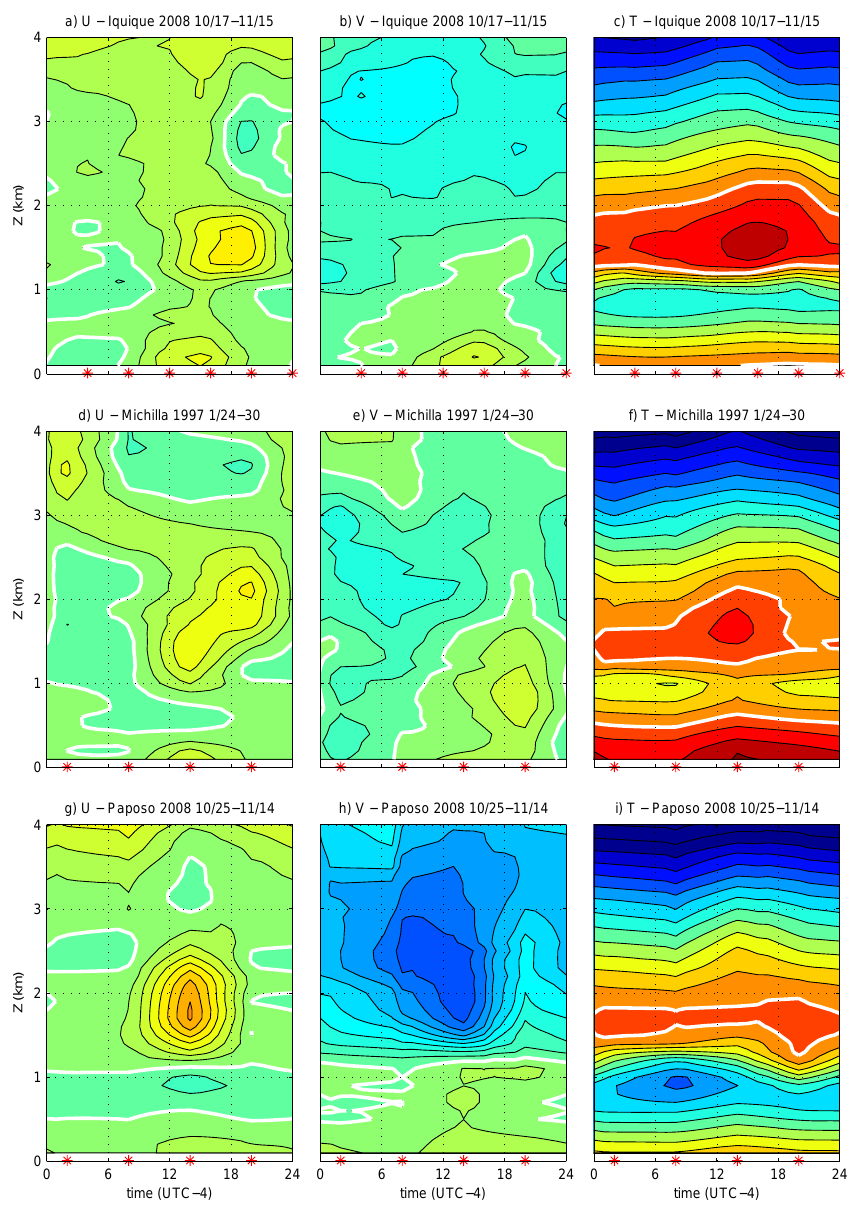
Fig. 2. Mean diurnal cycles from radiosonde data at Iquique and Paposo during VOCALS-REx, and from Michilla radiosondes in January 1997. Left panels: zonal wind component (1ms − 1 contours; white contour is 0ms − 1 ). Center panels: id. for the meridional wind compo- nent. Right panels: air temperature (1 ◦ C contours, white contour is 17 ◦ C). Red stars in the time axis represent observing hours. Averaging period for Paposo ranges from 25 October to 14 November, in which only five 02:00LT (UTC-4) radiosoundings are